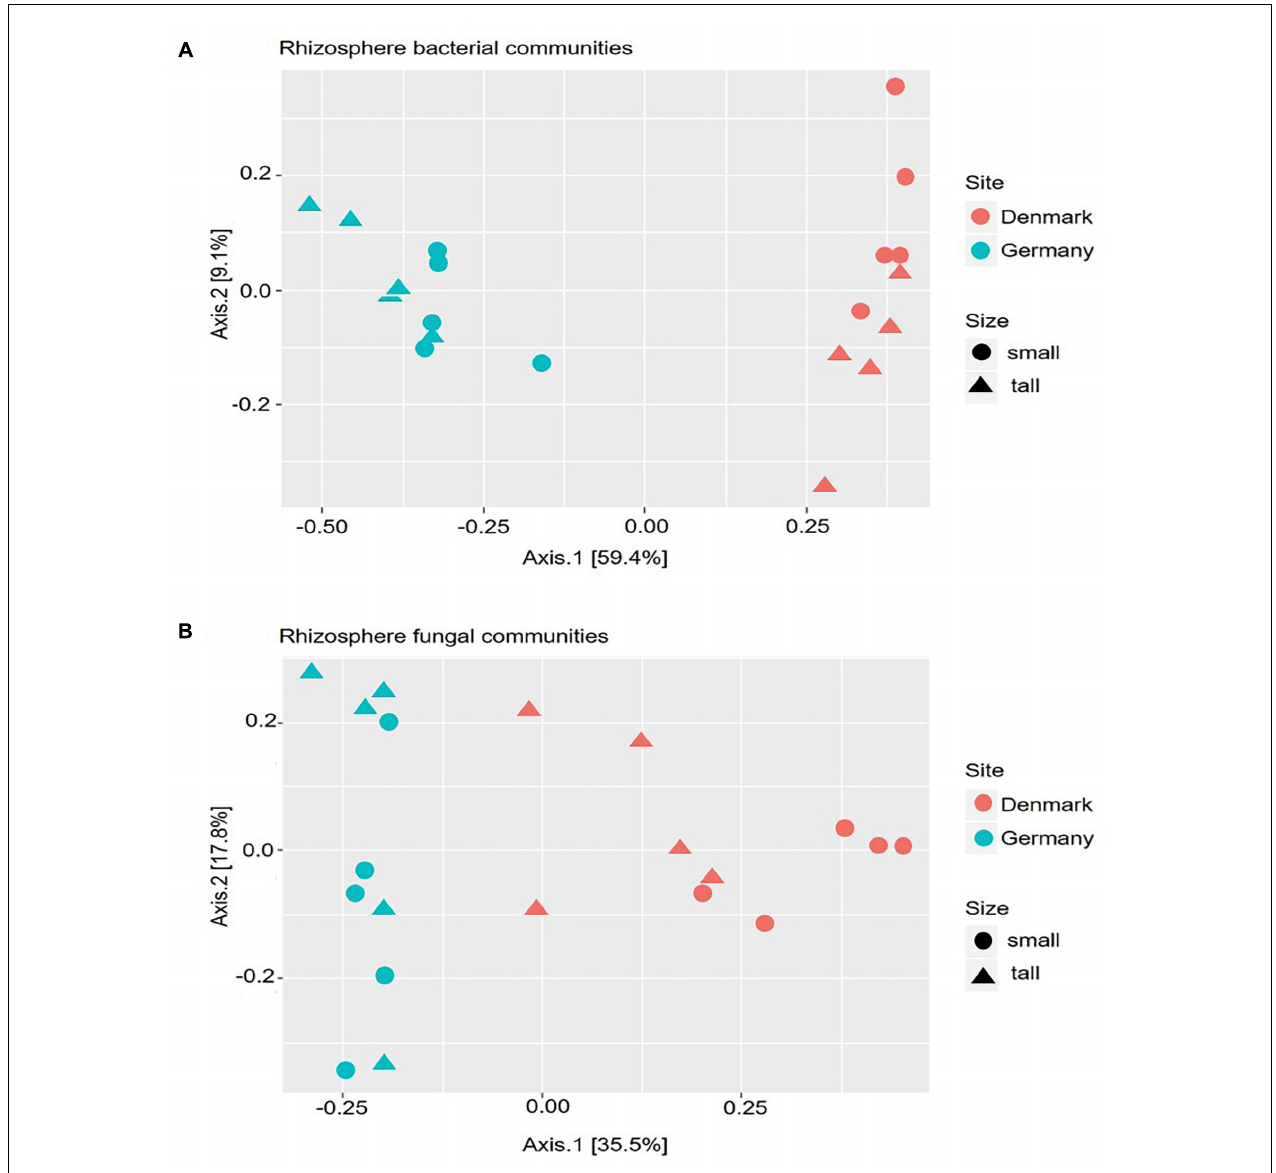
FIGURE 2 | Principal Coordinate Analysis (PCoA) based on the Bray–Curtis dissimilarity matrix between samples. Calculations are based on the operational taxonomic unit (OTU) distribution obtained from amplicon sequencing of the 16S rRNA gene (A) , and 18S rRNA gene (B) . DNA samples were obtained from rhizosphere of tall and small A. nordmanniana plants collected at the German and Danish sampling